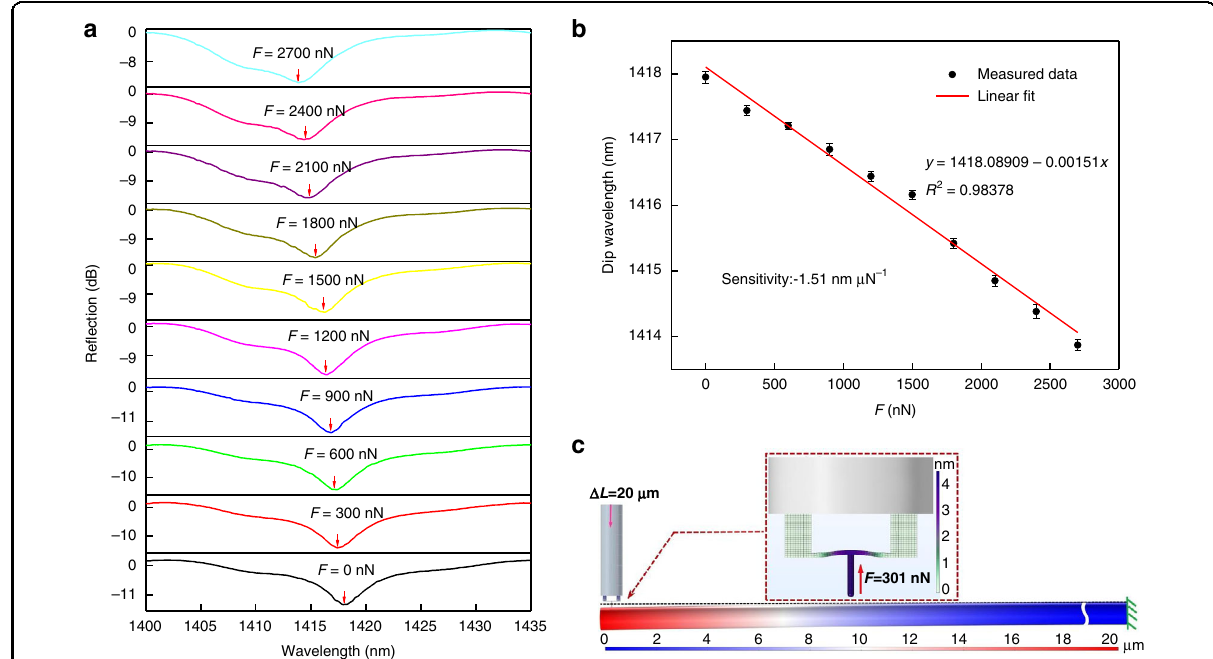
Fig. 5 Microforce measurements and simulation. a Evolution of re fl ection spectra of the sensor as the force increased from 0 to 2700 nN, as indicated by the arrows. b Dip wavelength versus force. The line is the linear fi tting of measured data points and the error bar is obtained by critically repeating the experiment of force measurement three times. c Simulation results of deformation distribution based on